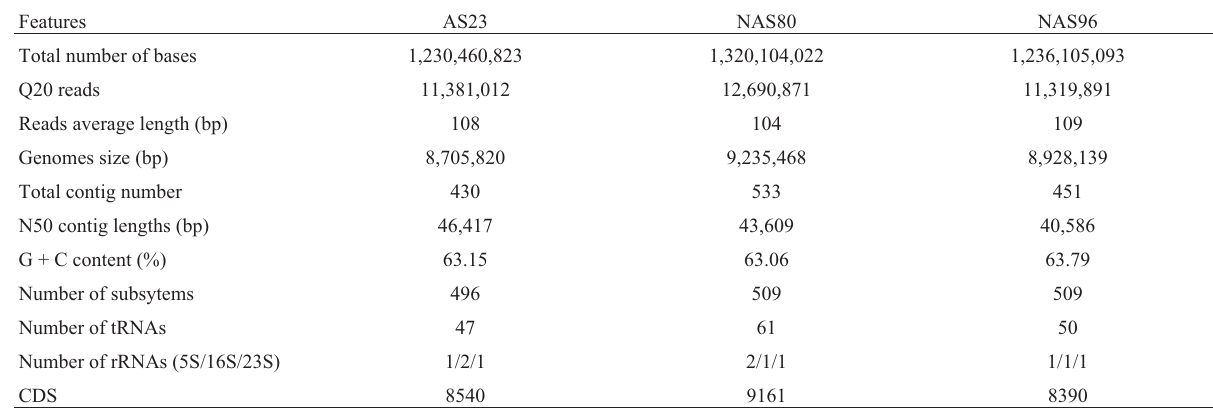
Table 1 - Genome features of three Bradyrhizobium sp. isolates (AS23, NAS80, and NAS96) symbionts of L. albescens